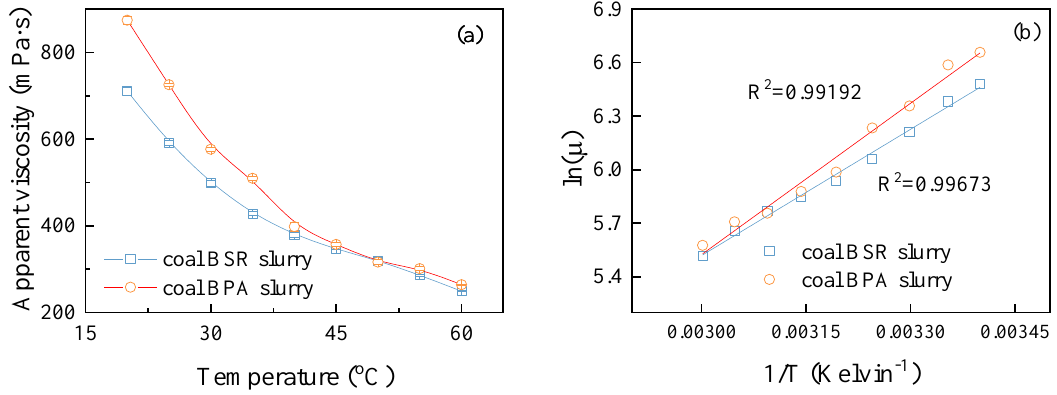
Figure 5. ( a ) Comparison of temperature–viscosity characteristics of coal BPA slurry (with concentration of 48%) and coal BSR slurry (with concentration of 33%). ( b ) Arrhenius fitting of temperature–viscosity relationship.